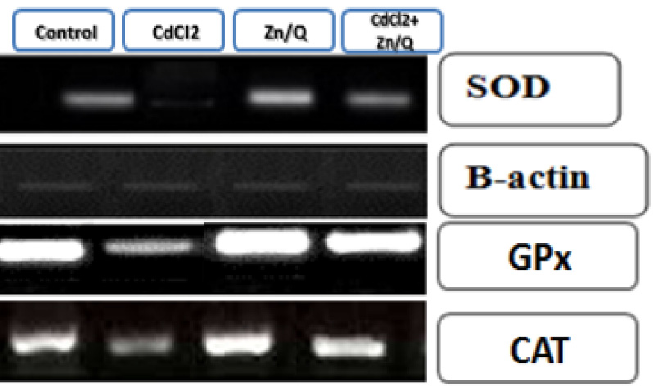
Figure 6. The genes expression of mSOD and m β -actin in hepatic tissues. 1: Control group; 2: CdCl 2 group only; 3: Zn/Q group; and 4: CdCl 2 +Zn/Q group. group only; 3: Zn/Q group; and 4: CdCl 2 +Zn/Q